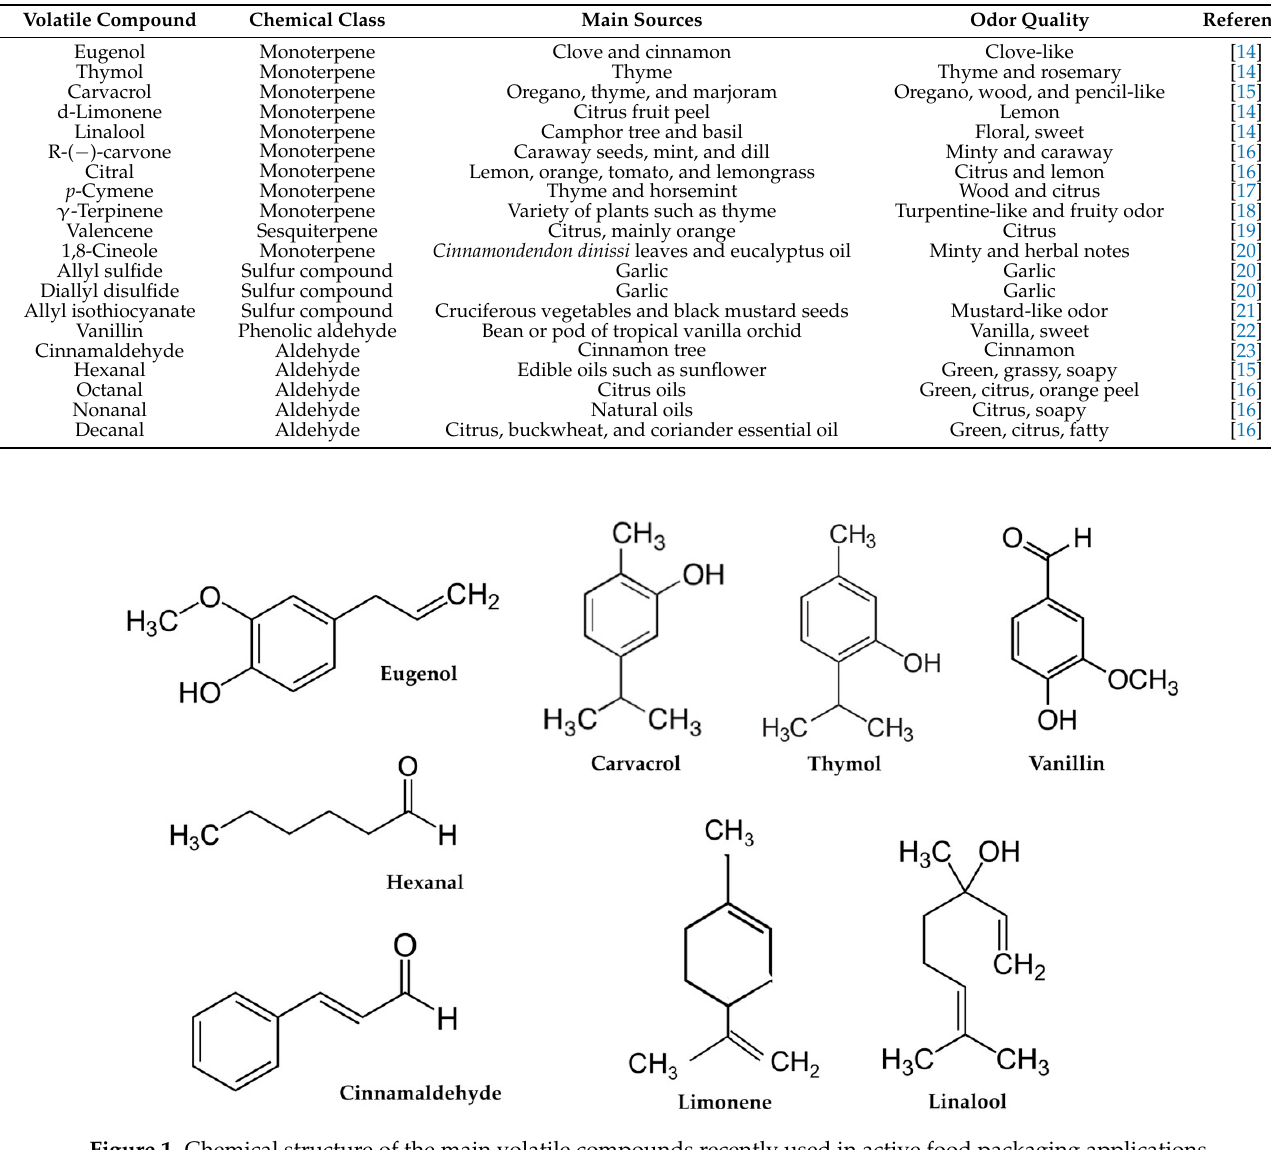
Figure 1. Chemical structure of the main volatile compounds recently used in active food packaging applications.